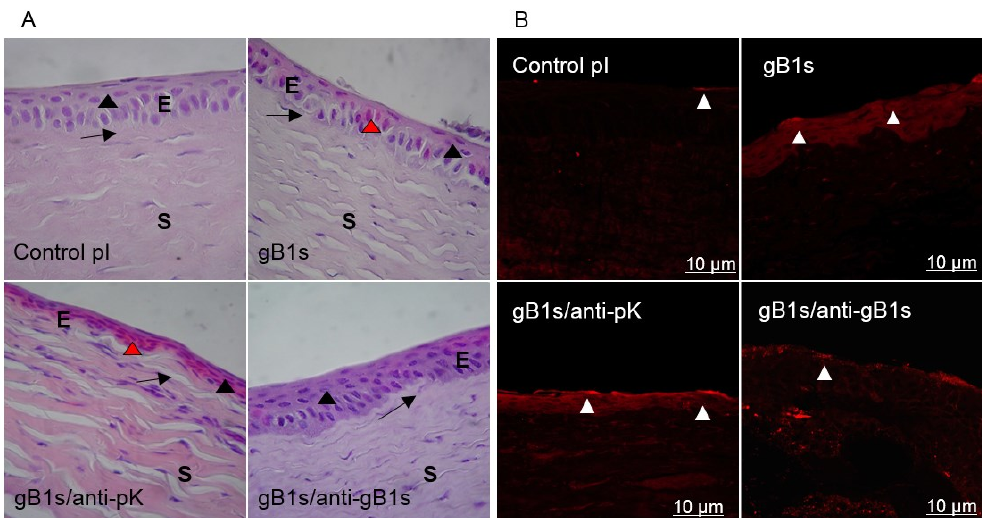
Figure 4. Morphological observations ( A ) and expression of TLR2 on the cell surface ( B ) in sections of rabbit corneal epithelium samples. ( A ) Hematoxylin-Eosin (H / E) stain. Epithelium (E), Stroma (S). The suprabasal layer (black arrowhead) and the basal layer (arrow) are indicated. Magnification 100 × . control; pre-immune (pI) rabbit serum as control sample; epithelial cells are columnar in basal layer while wing and surface cells are flattened. gB1s; in cornea treated with recombinant protein, epithelial cells are flattened, disarranged in all layers, some cells present Cowdry bodies (red arrowhead). gB1s / anti-pK; in cornea treated with recombinant protein preincubated with anti-pK gB1s pAb, epithelial cells are flattened and strongly eosin stained. gB1s / anti-gB1s; with recombinant protein preincubated with anti-gB1s pAb, cells of the basal layer became columnar and in the suprabasal layer are flattened (as in the control in pI). ( B ) Immunofluorescence staining with anti-TLR2 Ab on abraded cornea exposed to: control pI; pre-immune rabbit serum as control sample; gB1s recombinant protein; gB1s / anti-pK, gB1s preincubated with anti-pK gB1s pAb; gB1s / anti-gB1s, gB1s preincubated with anti-gB1s